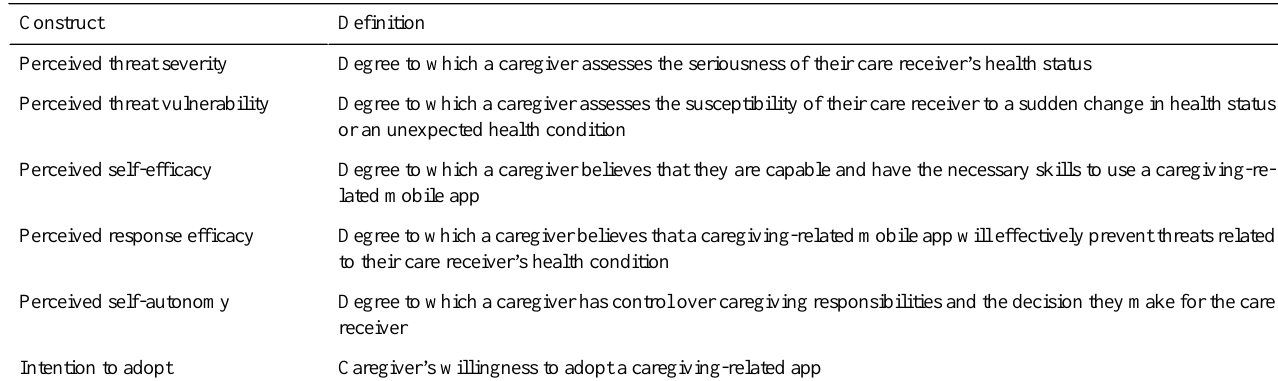
Table 1. Definitions of constructs.